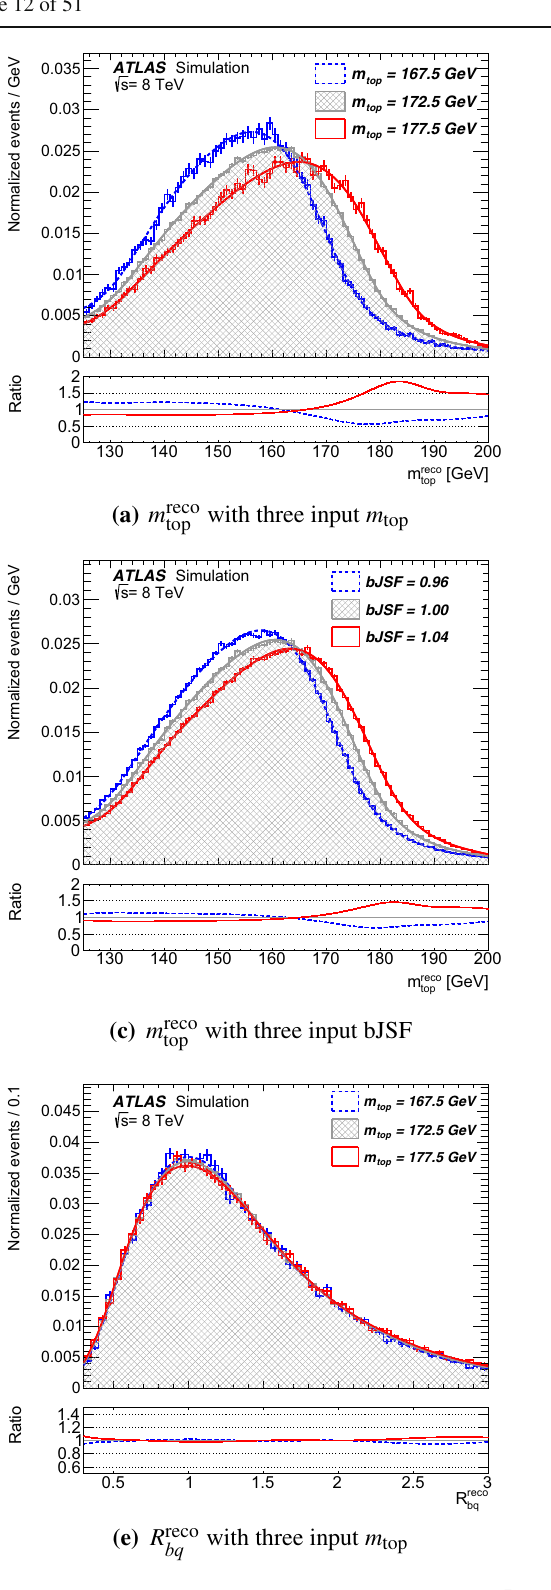
Fig. 5 Template parameterizations for signal events, composed of t ¯ t overlaid with the corresponding probability density function from the and single-top-quark production events. a – c show the sensitivity of combined fit to all templates described in the text. The ratios shown m reco m top , JSF and bJSF, d shows the sensitivity of m reco to JSF are calculated relative to the probability density function of the central top to W and e , f show the sensitivity of R reco to m top and bJSF. Each template is sample with m top = 172 . 5 GeV, JSF = 1 and bJSF = bq